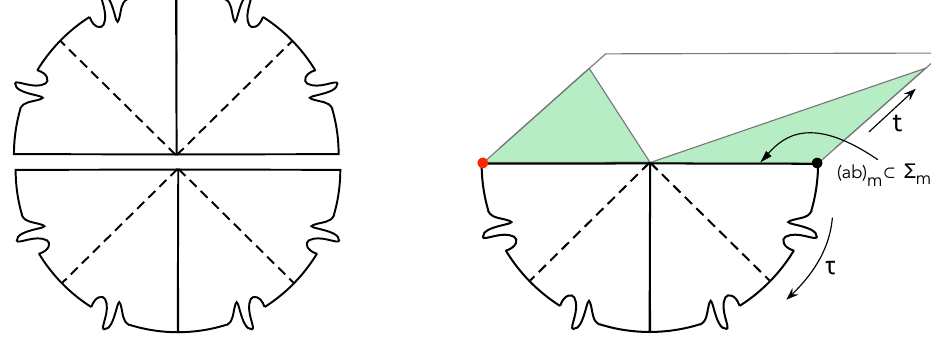
Figure 9 . Left: the LM bulk replica picture for m even. Each wedge is a bulk region that is associated with a copy of the replicated boundary region AB . The solid and dashed lines end at the boundary on a fixed time slice that is a fixed point of the time reflection symmetry on each replica. There is an enhanced dihedral symmetry and we have cut the bulk into two along the moment of time reflection symmetry governed by τ defined in the text. Right: continuing into real time based on this time reflection symmetry in the standard way. of figure 9. These solid curves represent the “entanglement wedge” region r ( AB ) ≡ ( ab ) ; m m i.e. the homology region between the Z fixed point and the AB region on the boundary m of a fixed replica. The bulk density matrix is defined on the ( ab ) Hilbert space which can m then be doubled in the usual way. The pure state (5.1) is defined in this doubled Hilbert